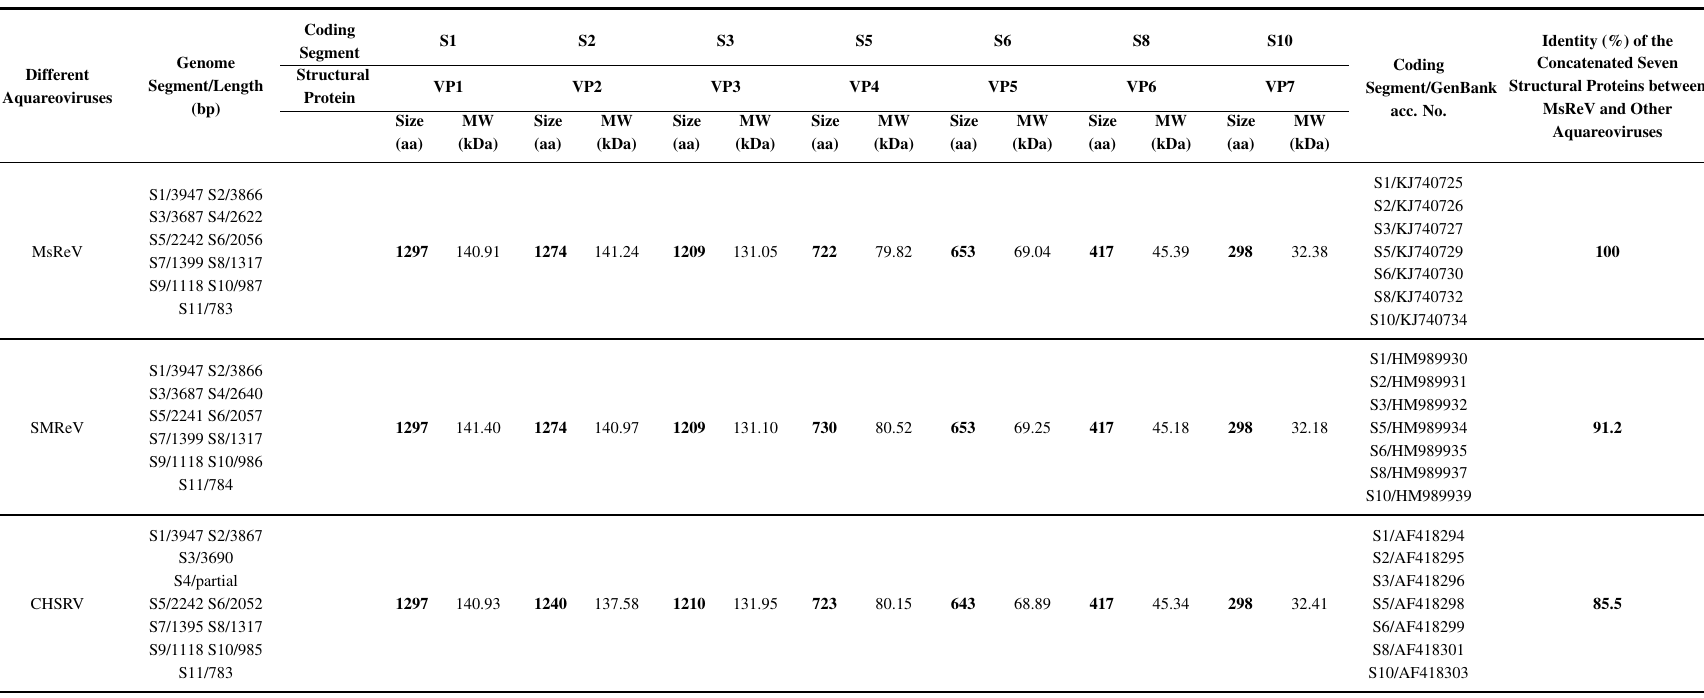
Table 1. Summary of genome segments and encoded structural proteins of 13 aquareoviruses and percent sequence identities of the concatenated seven structural proteins between MsReV and other